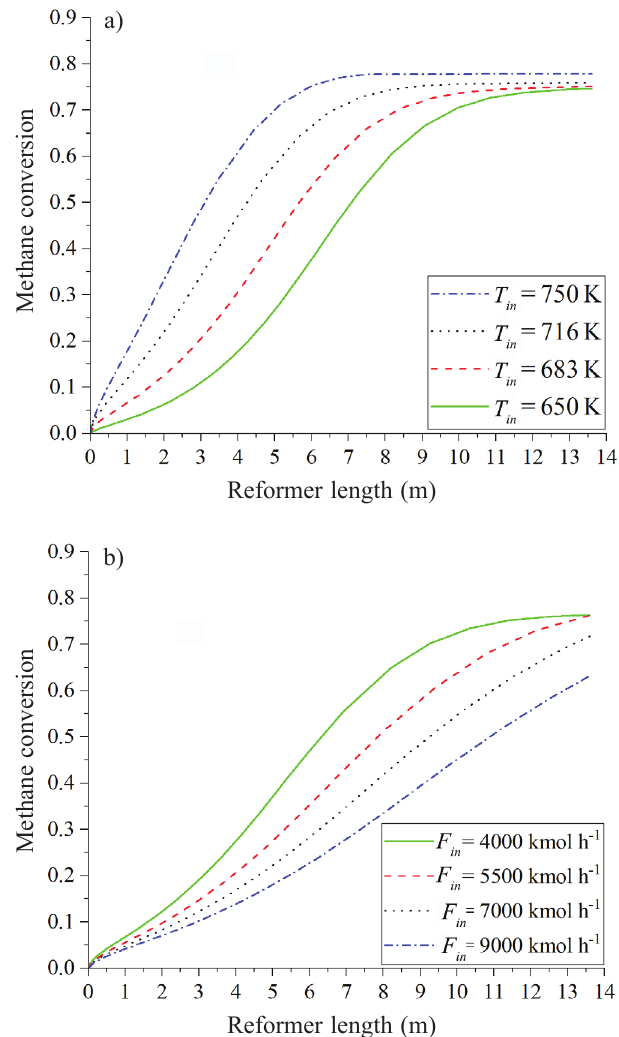
Fig. 4 – Effects of feed temperature (a), and flowrate (b) on methane conversion